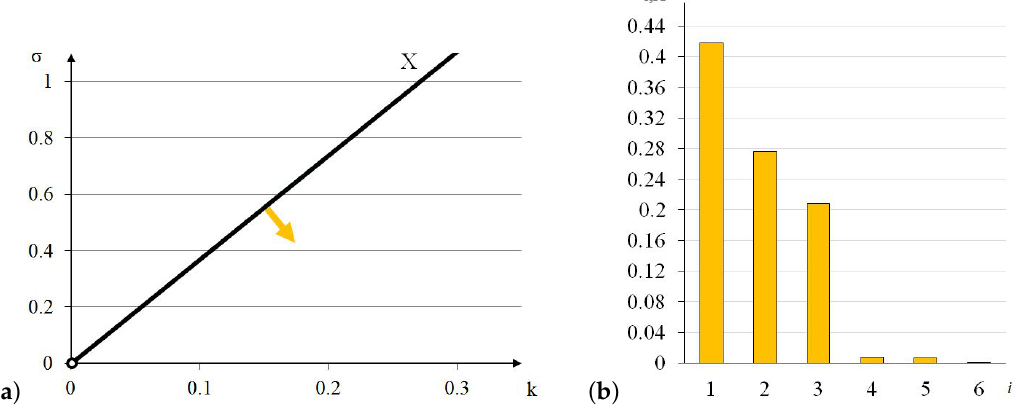
Figure 17. Extreme properties of the X-module: ( a ) Line of extreme properties σ = 0.001 + 3.69 · k . ( b ) Distribution of eigenvalues for k = 0.1, σ = 0.370 (multiplier EA / a 2 ).